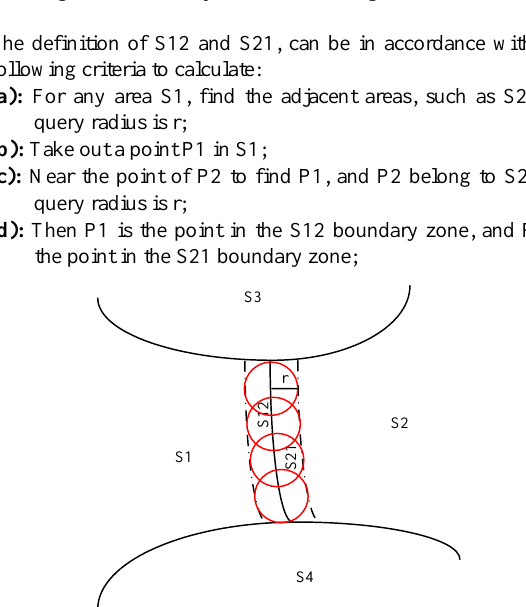
Figure 7. Range of boundary zone in connected